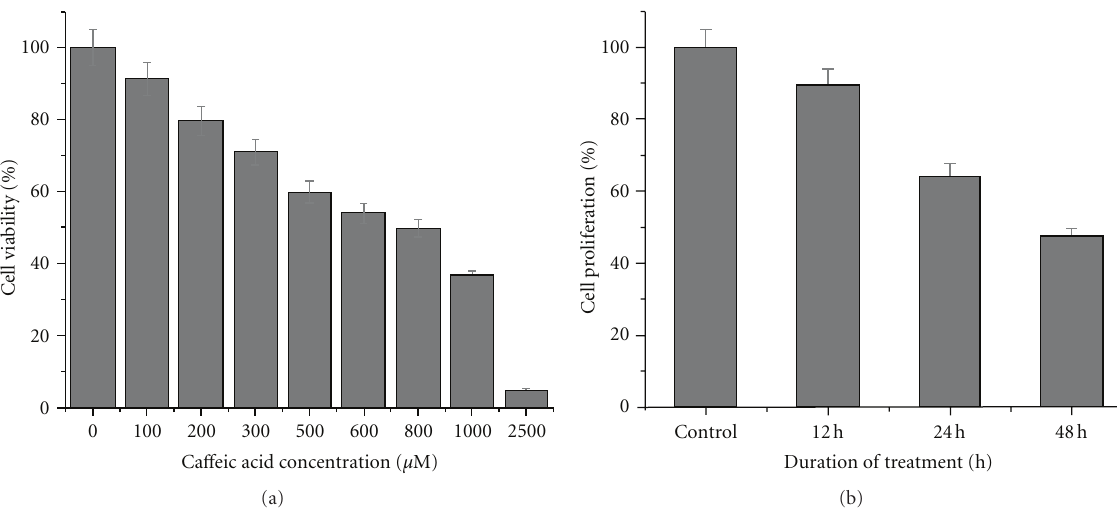
Figure 1: Antiproliferative e ff ect of ca ff eic acid against colon cancer cells growth in vitro. (a) HCT 15 cells grown in 96-well plates were treated with various concentrations of ca ff eic acid diluted in the RPMI media for 48 h. The mean of the percentage cell viability (% of untreated HCT 15 cells) along with their standard error is indicated. (b) After various incubation periods of ca ff eic acid treatment, colonies formed were stained with 0.5% crystal violet and counted, and percentage of survival was calculated. Data reported as the mean ± SE from three di ff erent observations. Means are significant at 24 and 48h ( P < 0 .